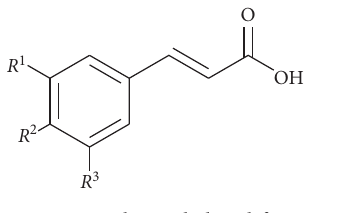
Figure 11: 2-Carboxyethyl aryl fragment.